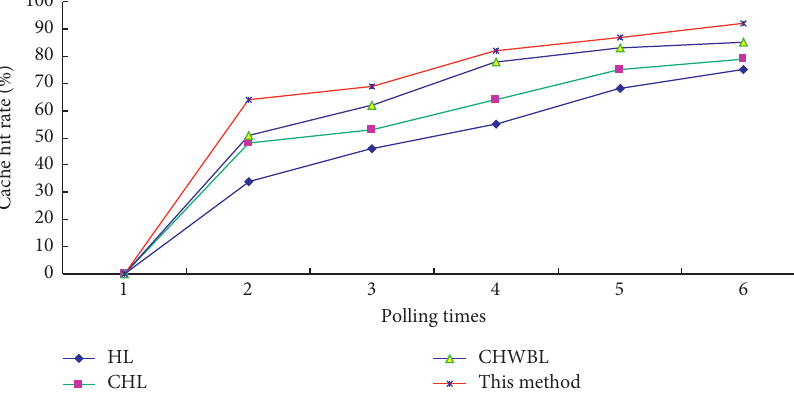
Figure 10: Comparison results of cache node hit rate under different